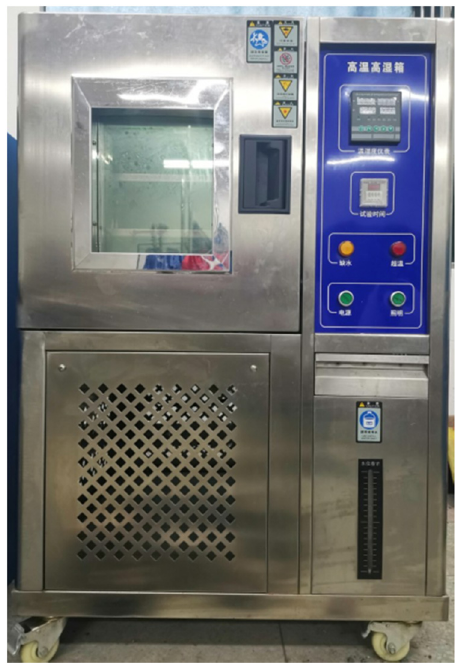
Figure 2: Climatic chamber for hydrothermal aging.